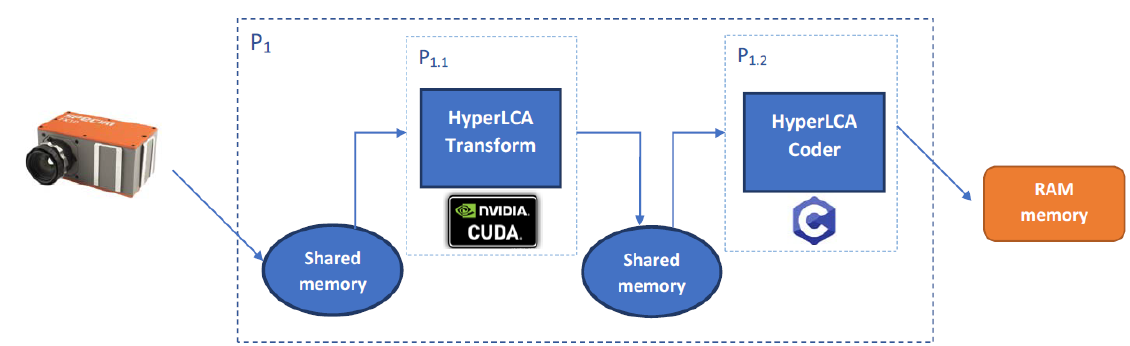
Figure 4. Previous work design for the real-time compression of the hyperspectral data. Ring buffers are used to prevent the saturation of the RAM memory of the board. These ring buffers allow for a maximum number of frames to be stored at the same time in the memory. Once that the last position of the ring buffer is written, it returns to the first one, overwriting the information that is present in this position. This methodology is able to achieve real-time performance and very high compression speeds, as demonstrated in